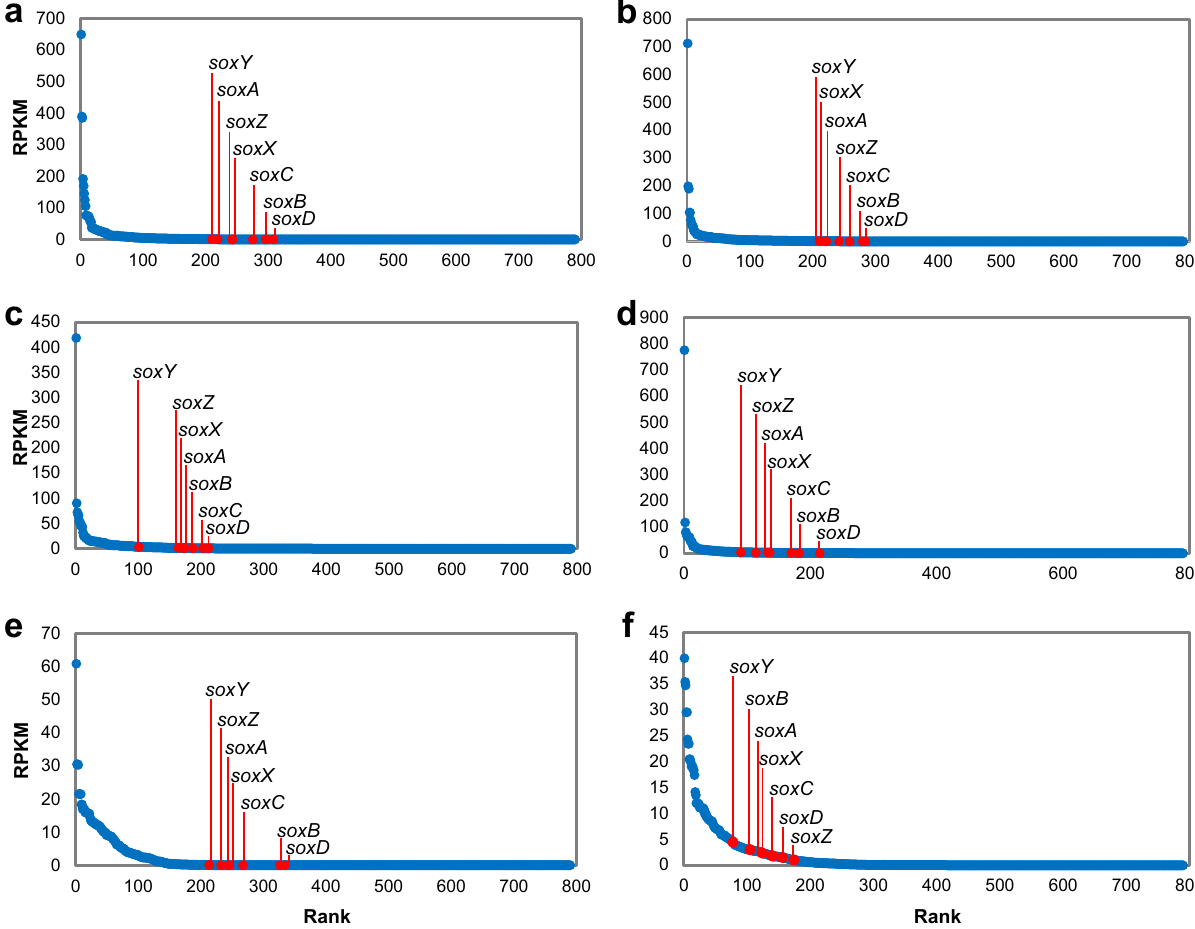
all the energy metabolism KEGG genes are based on their Reads Per Kilobase per Million mapped reads (RPKM) values. Source data are provided as a Source data fi